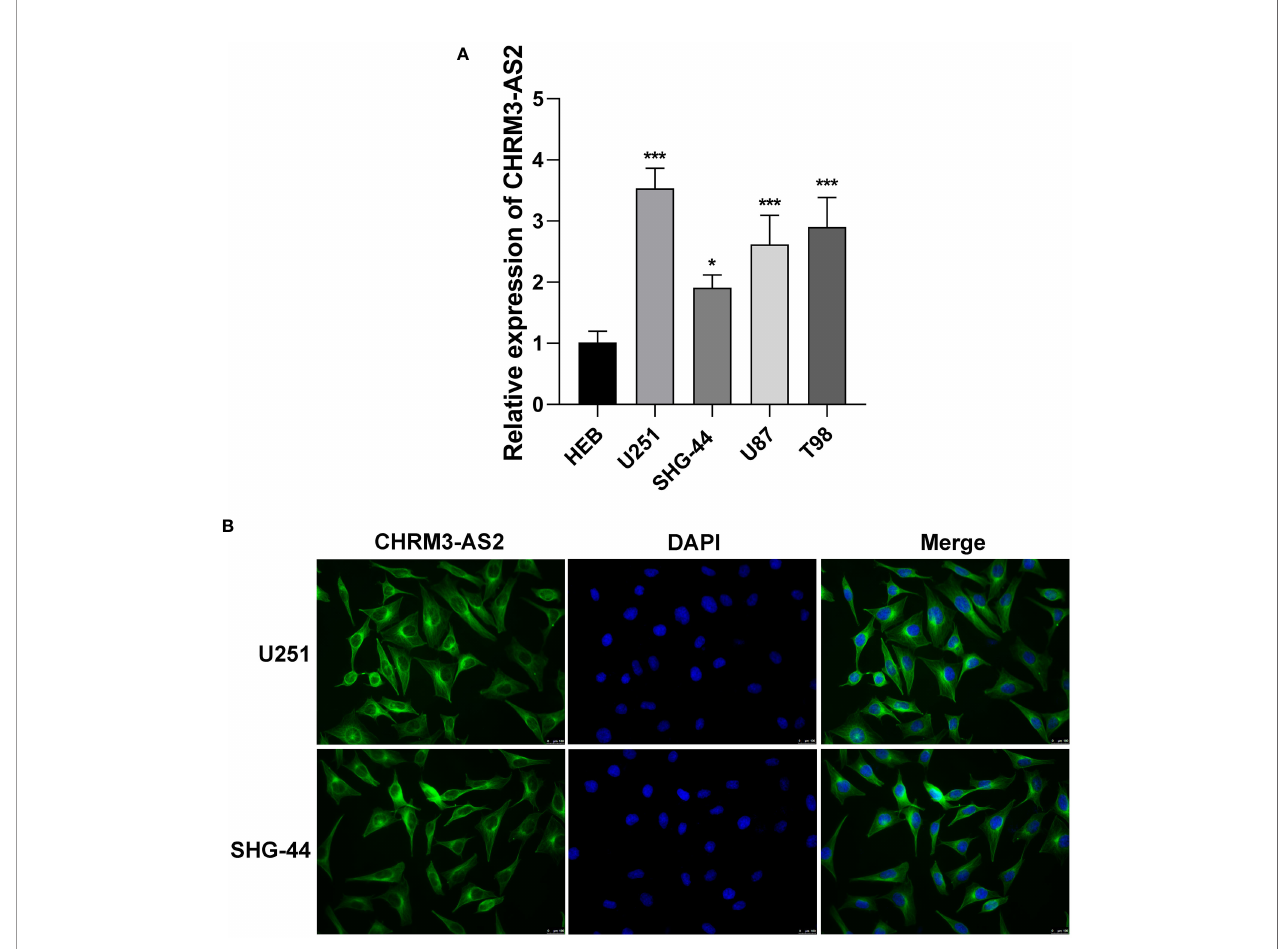
FIGURE 2 | Up-regulation of expression of CHRM3-AS2 localised in the cytoplasm of glioma cells. (A) Expression of CHRM3-AS2 in a normal human glial cell line (HEB) and four glioma cell lines (U251, SHG-44, U87, and T98) was quanti fi ed via qRT-PCR. (B) Subcellular localisation of CHRM3-AS2 was determined via FISH in U251 and SHG-44 cells. *P < 0.05, ***P < 0.001 vs.